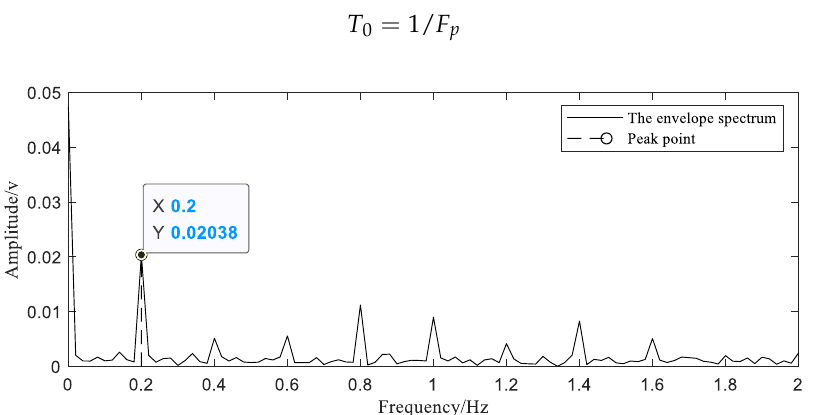
Figure 11. The envelope spectrum of the current signal after resampling.